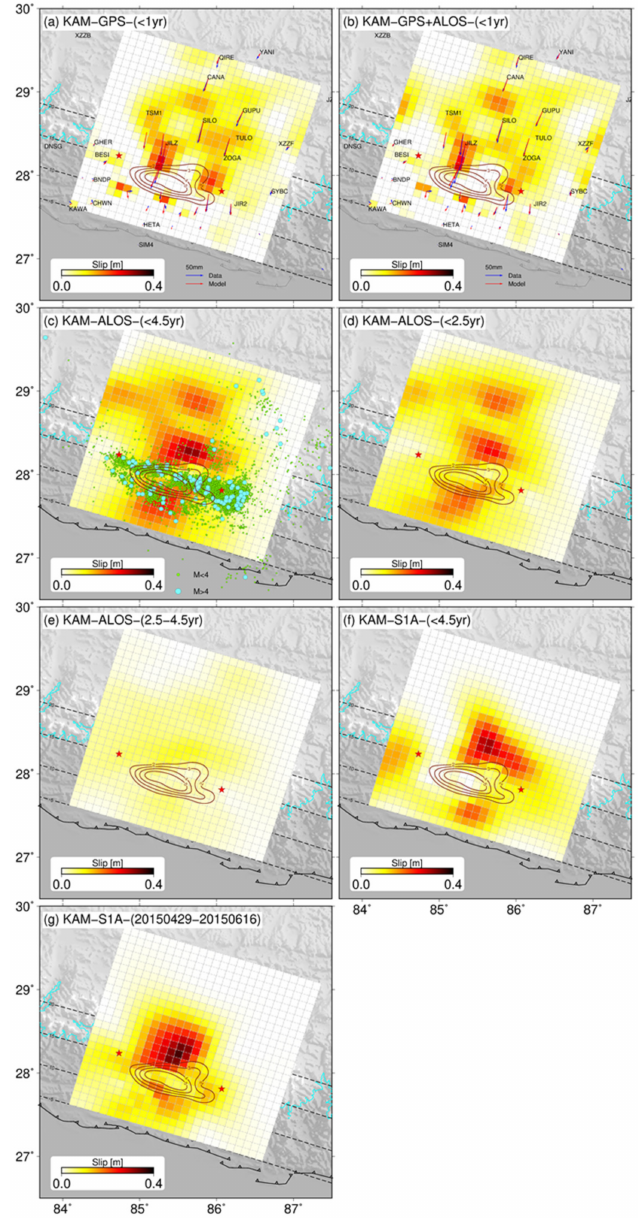
Figure 11. The Kinematic afterslip model of InSAR and GPS data; ( a ) constrained by GPS data in 1 yr after the mainshock; dotted lines and contours indicate fault depth and co-seismic slip, respectively; ( b ) constrained by ALOS-2 and GPS data in 1 yr; ( c ) constrained by ALOS-2 data in ~4.5 yr (2015– 2019), the green and light-blue areas represent the aftershocks; ( d ) constrained by ALOS-2 data in ~2.5 yr (2015–2017); ( e ) constrained by ALOS-2 data in 2.5–4.5 yr (2018–2019); ( f ) constrained by Sentinel-1 ascending and descending orbit data obtained by PS-InSAR in ~4.5 yr; ( g ) constrained by Sentinel-1 data obtained by